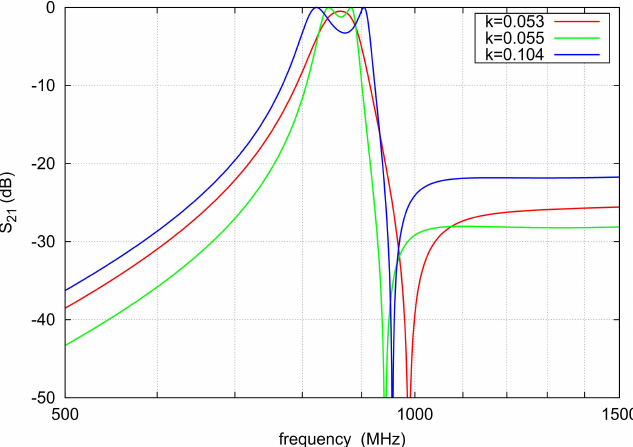
Figure 4. Exemplary s 21 characteristics of the proposed filter for three values of the coupling coefficient: k = 0.053 ( C 1 = 2.85 pF, L 1 = 8.8 nH, L 2 = 2.66 nH, L 3 = 0.34 nH), k = 0.055 ( C 1 = 3.15 pF,